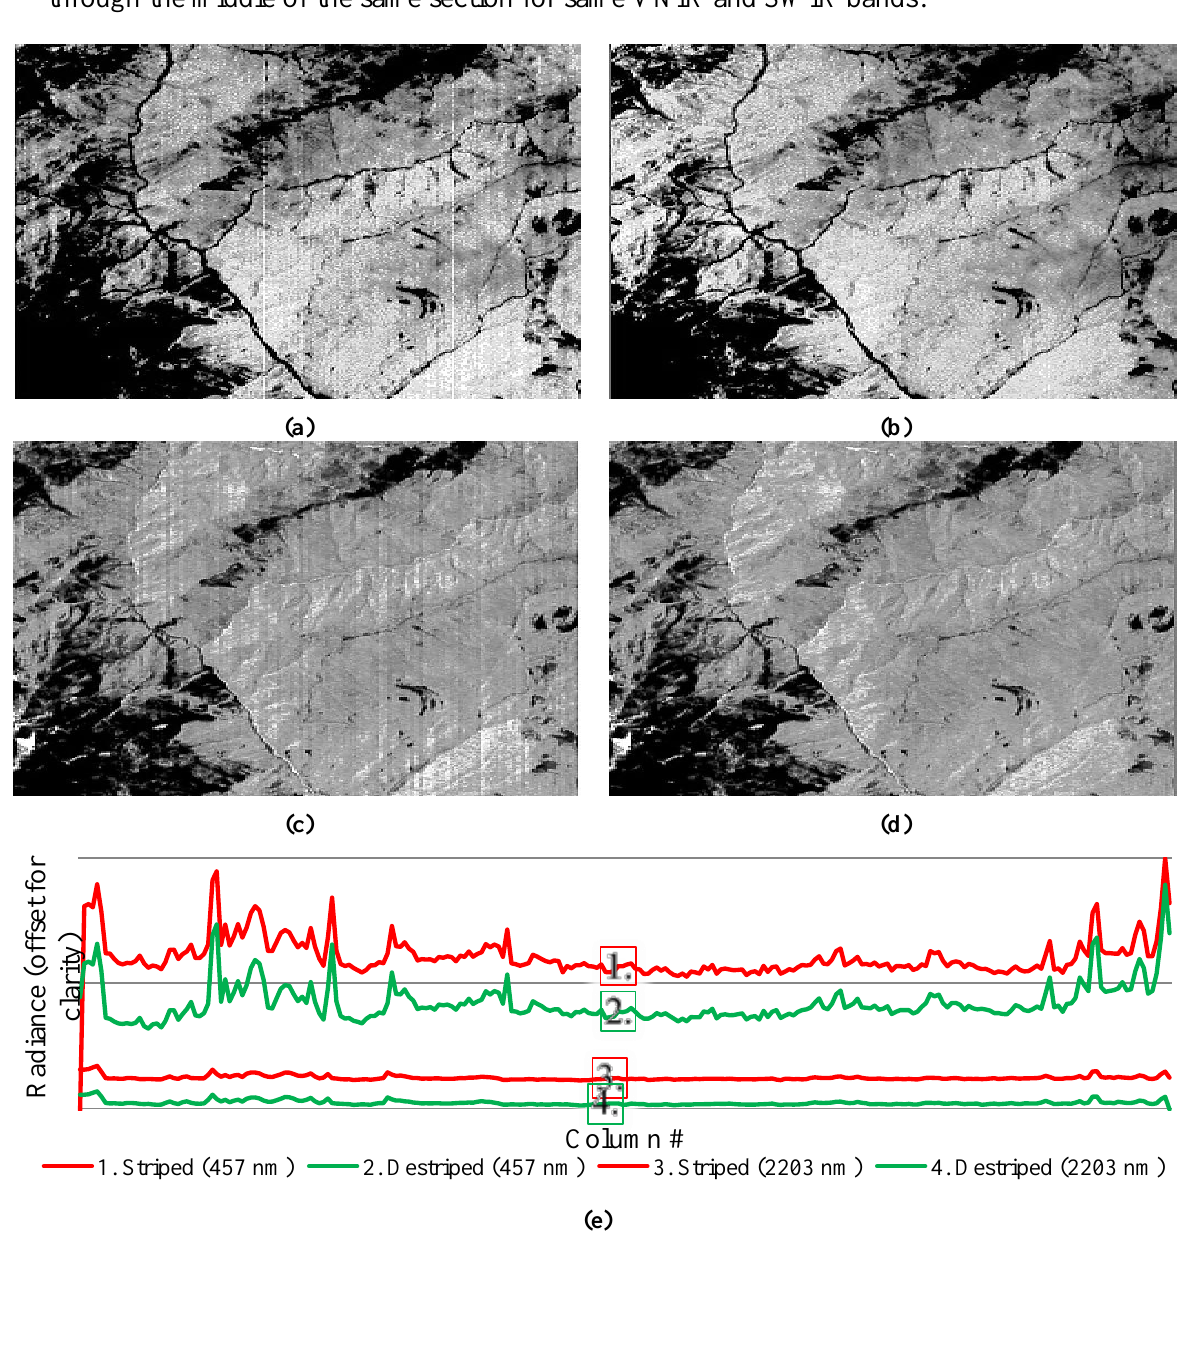
Figure 7. Exemplary grey scaled, striped images of sections in the middle of a Hyperion scene (VNIR-band 11–457 nm (a) , SWIR-band 205–2203 nm (c) and their respective radiometrically recalibrated results (VNIR (b) , SWIR (d) as well as a transect plot (e) through the middle of the same section for same VNIR and SWIR